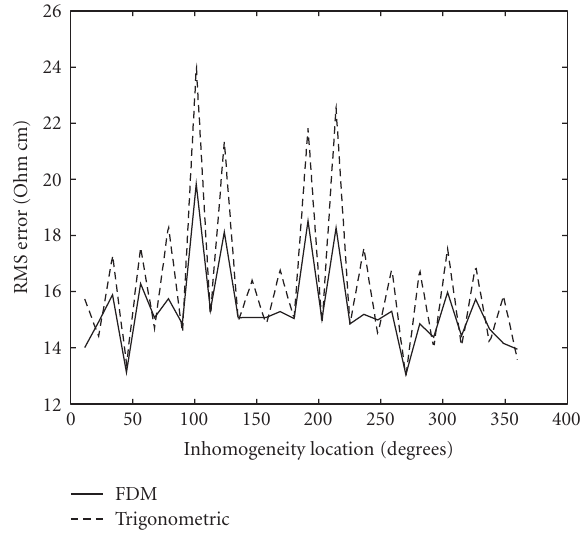
Figure 8: Error of the reconstruction for the trigonometric current pattern and the FDM pattern as a function of the inhomogeneity location.